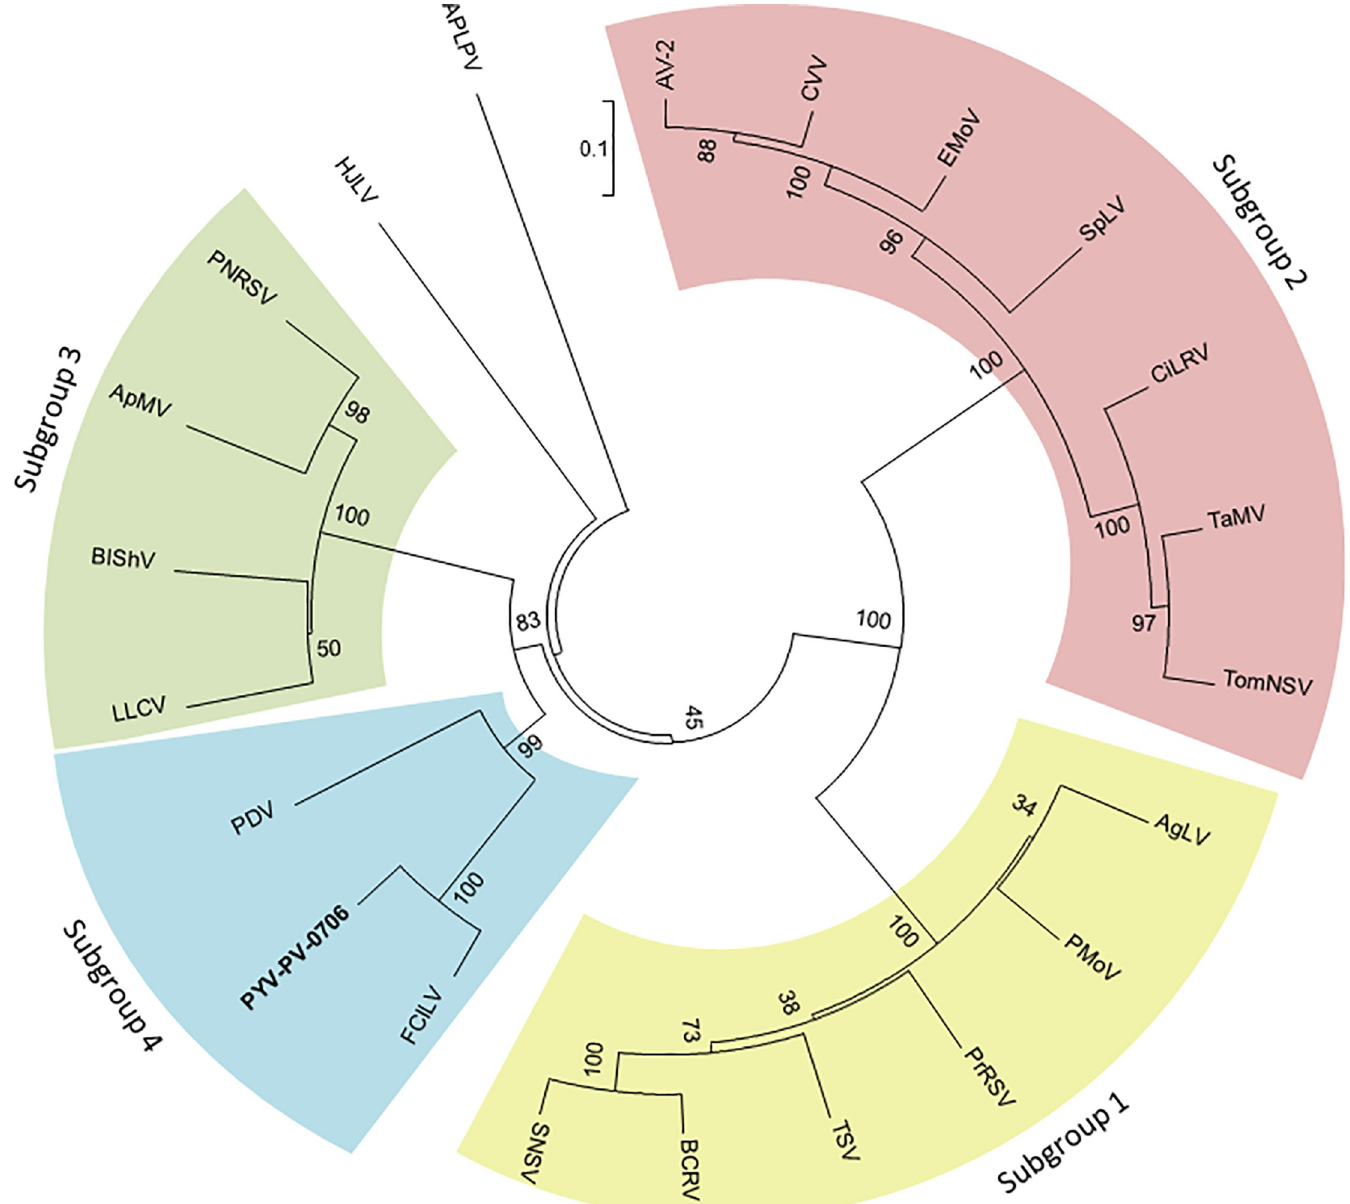
Fig 2. Phylogenetic tree based on RdRp amino acid sequence alignment of members of the genus Ilarvirus . Bootstrap values (%) are shown at the nodes. Virus names and GenBank accession numbers are given in Table 1.